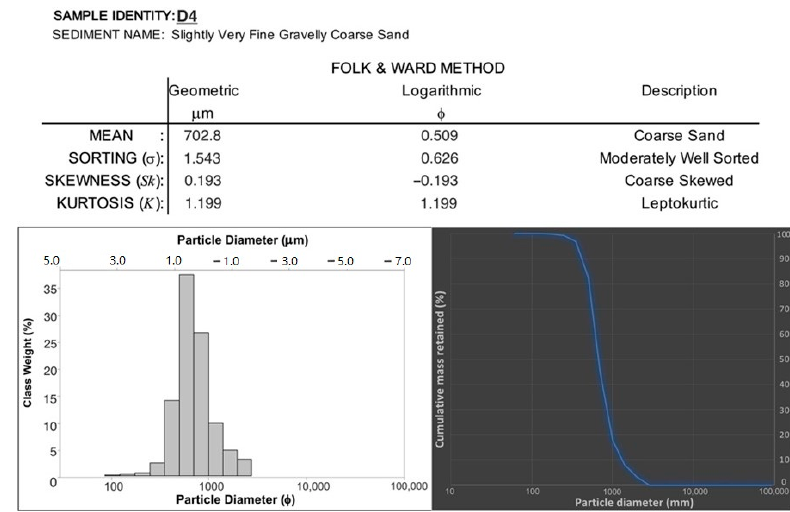
Figure 4. Example of a grain-size analysis using Gradistat© (v8).